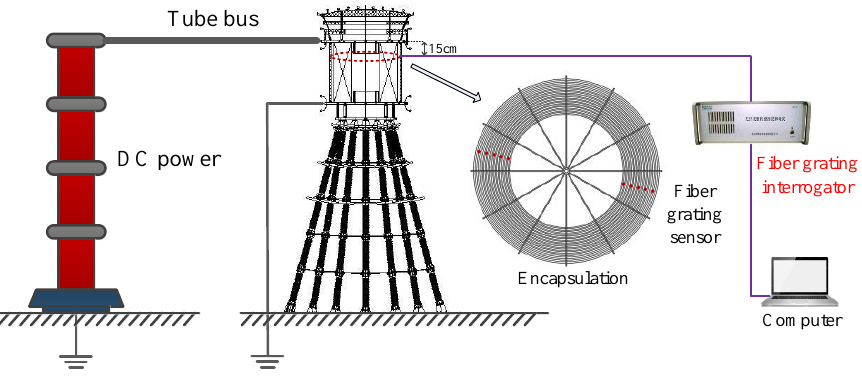
Figure 8. Schematic diagram of the temperature rise test.